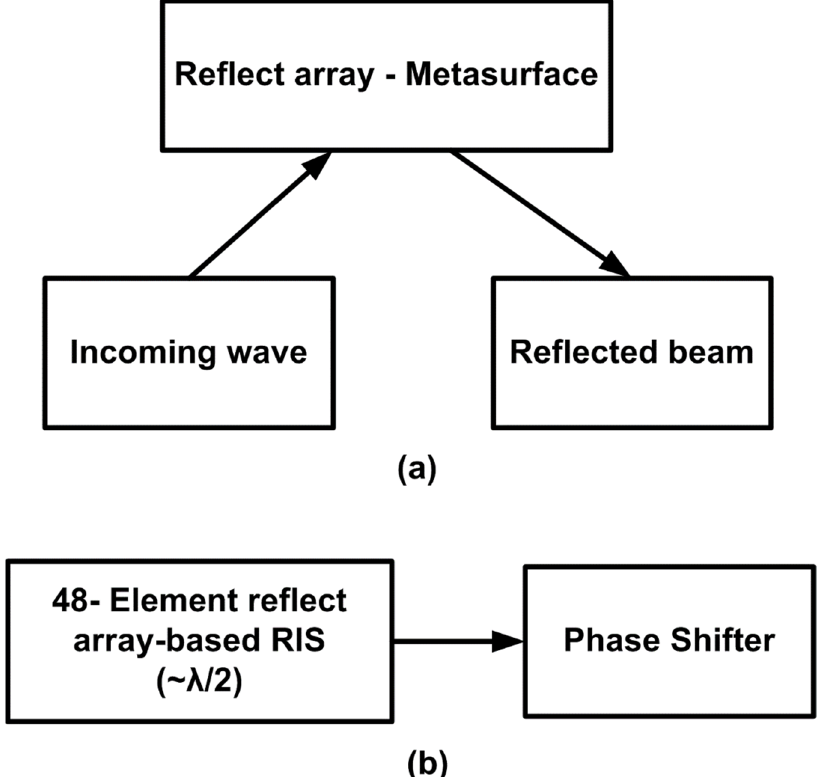
Figure 3. ( a ) Reconfigurable Intelligent Surface (Reflectarray) ( b ) Reflectarray RIS implementations: A 48-element reflect array-based RIS. Each element is a traditional antenna connected to a phase shifter.